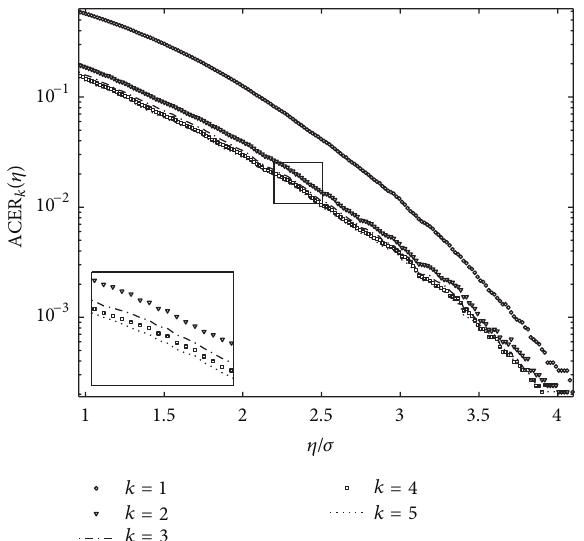
Figure 15: Comparison between ACER estimates for different degrees of conditioning based on the time series of the peak values, compared with Figure